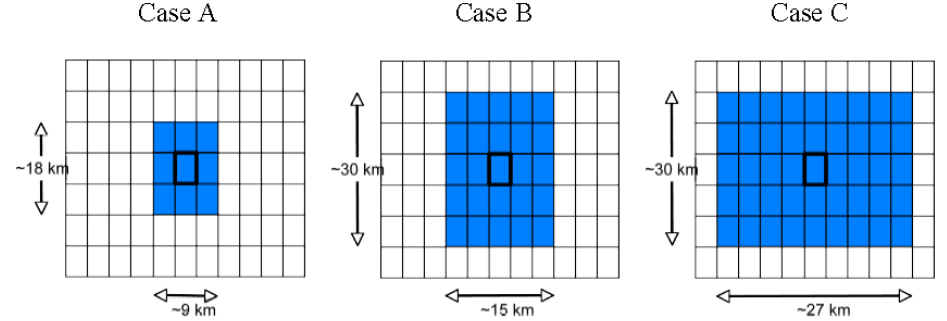
Fig. 3. Schematic of the neighbouring ground pixels included in the edge test. Sizes for the blue areas are given for the MSG SEVIRI data. The pixel that is tested is the centre pixel in each figure. Left figure shows a test with 1 neighbour included in all directions (Case A). The middle figure shows a test with 2 neighbours included in each direction (Case B). The right figure shows a constraint with 4 neighbours in the East-West direction and 2 in the North-South direction (Case C).